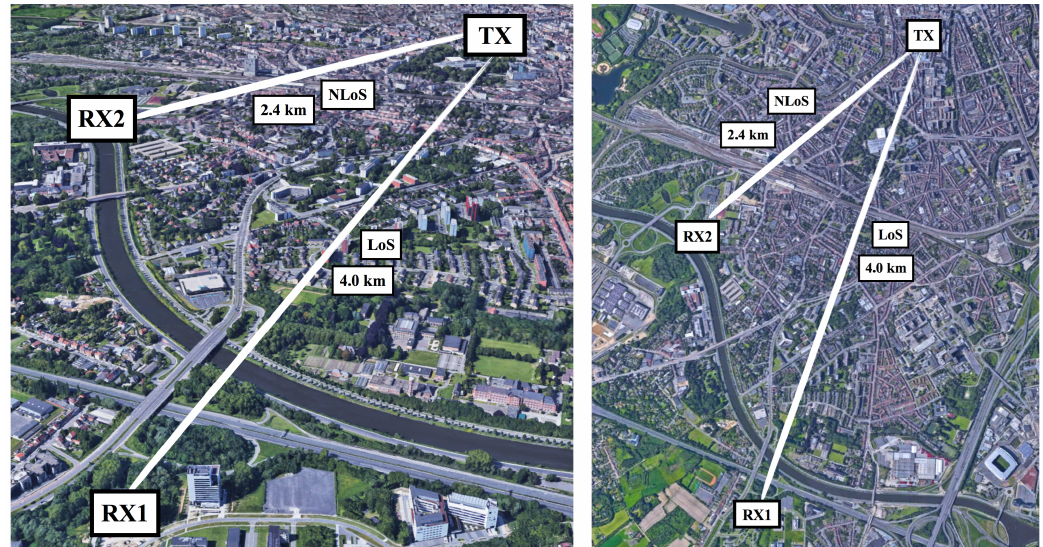
Figure 6. 3D and satellite views of the outdoor node locations. Map Data: Google, Landsat/Copernicus.